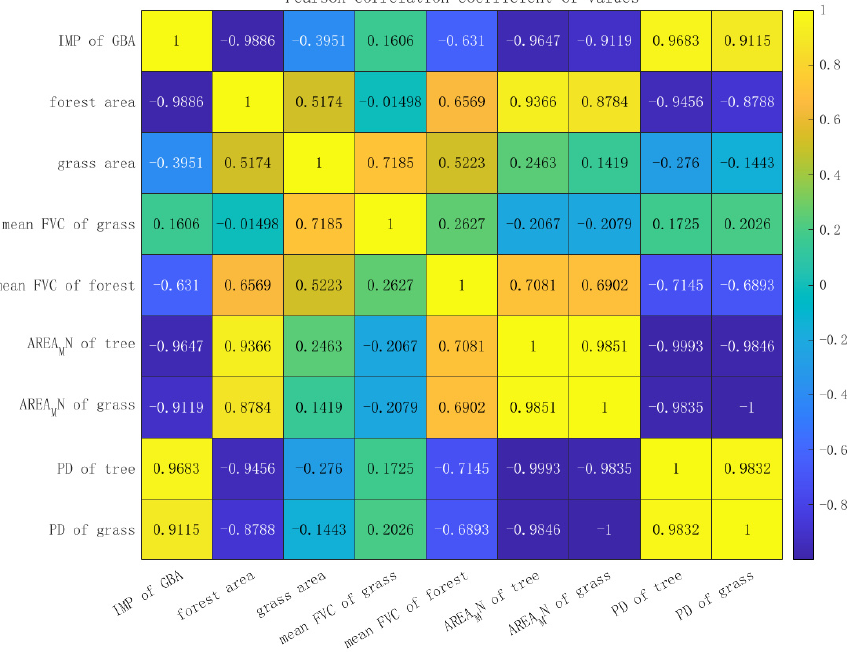
Figure 12. The correlation